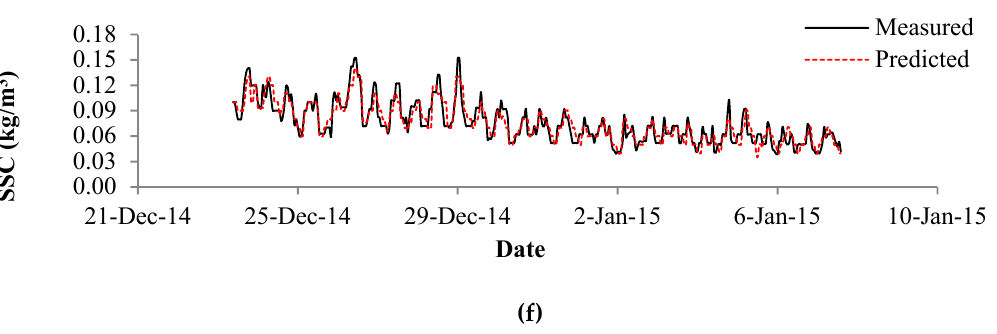
Figure 7. Comparison between simulation results and field measurements on 23 December 2014 to 7 January 2015 at station 1 (long: 101°20 ′ 11.18” E, lat: 02°48 ′ 40.02” N), ( a ) current speed; ( b ) current direction; ( c ) water level; ( d ) significant wave height; ( e ) mean wave direction; ( f ) SSC.